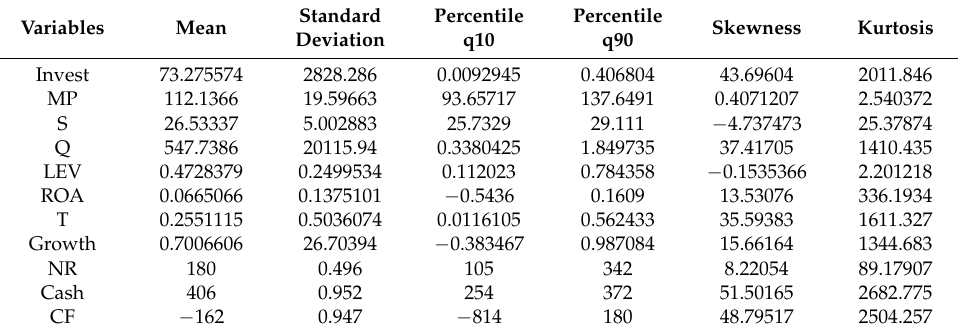
Table 2. Statistical description of variables used for validation in the